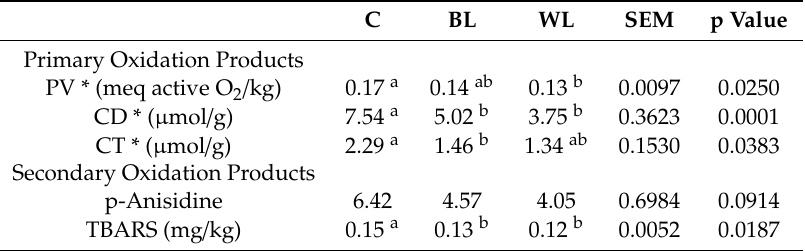
Table 6. E ff ect of dietary phytoadditives on egg yolk oxidative stability during storage.